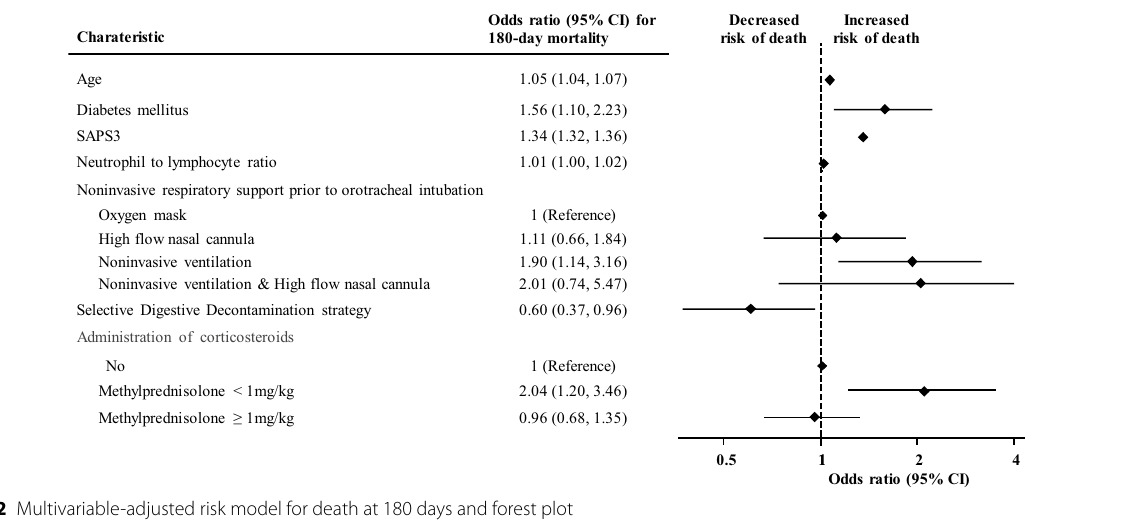
Noninvasive respiratory support prior to orotracheal intubation